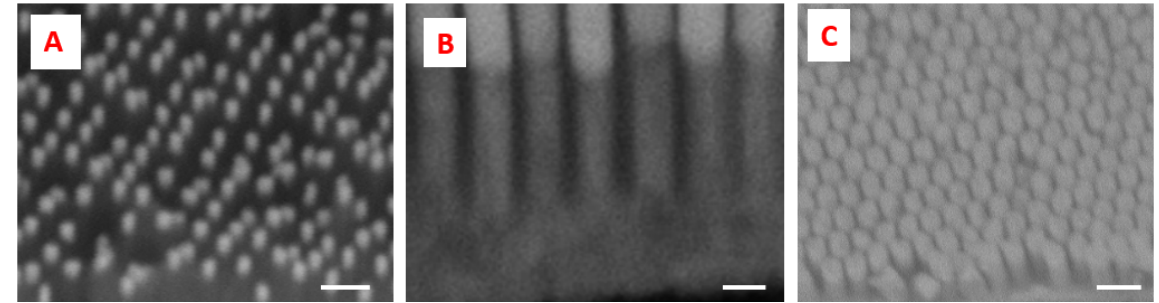
Figure 5. SEM micrographs. Fe-Au nanowires with distance between wires 40 nm ( A ), scale bar = 200 nm, 15 nm ( B ), scale bar = 90 nm and 5 nm ( C ), scale bar = 180 nm.